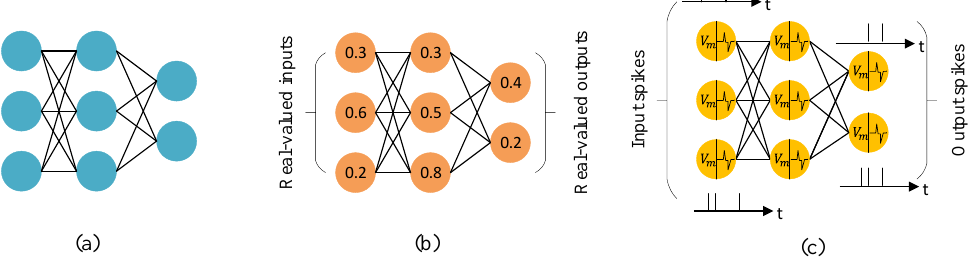
Figure 1. Behavioral differences between ANN and SNN models. ( a ) a general architecture of 2-layer network; ( b ) a 2-layer ANN architecture; and ( c ) a 2-layer SNN